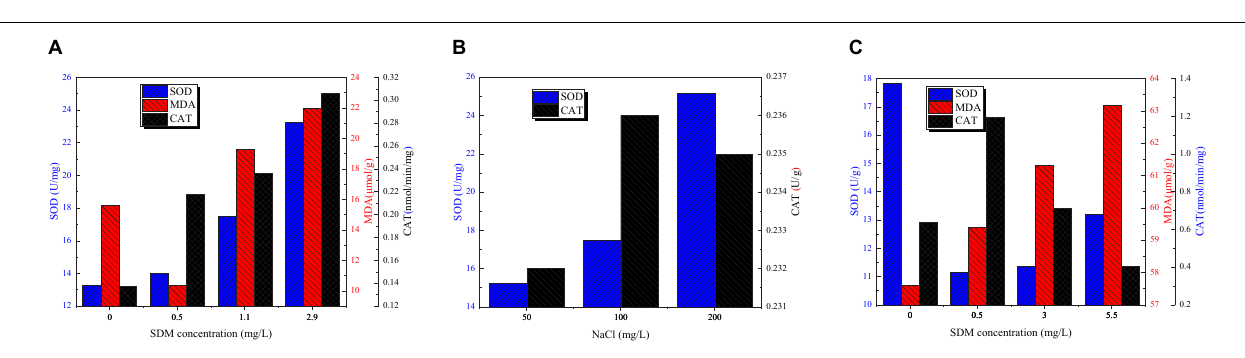
FIGURE 4 | Superoxide dismutase (SOD) (A) , malondialdehyde (MDA) (B) , and catalase (CAT) (C) content variation of Chlorella sp. L38 and Phaeodactylum tricornutum MASCC-0025 under different SDM